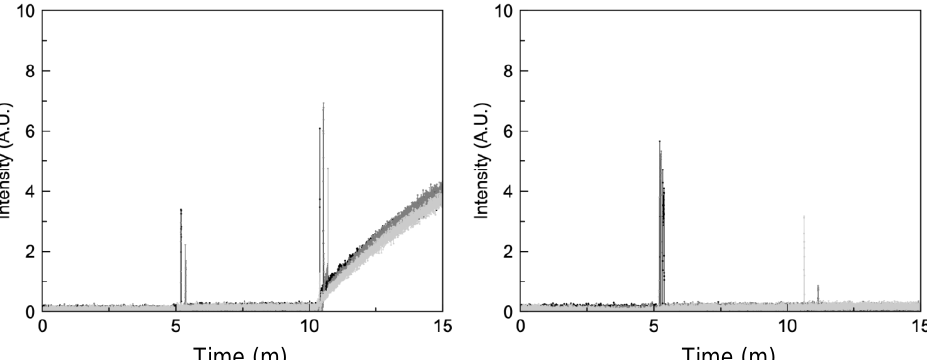
Figure 6. Fluorescence intensity of liposomal FluoZin-3 in PBS buffer (0.1 M, pH = 7.4) before and after addition of zinc and ( a ) clioquinol or ( b ) hydroxychloroquine at the ~10 – 11 min mark.